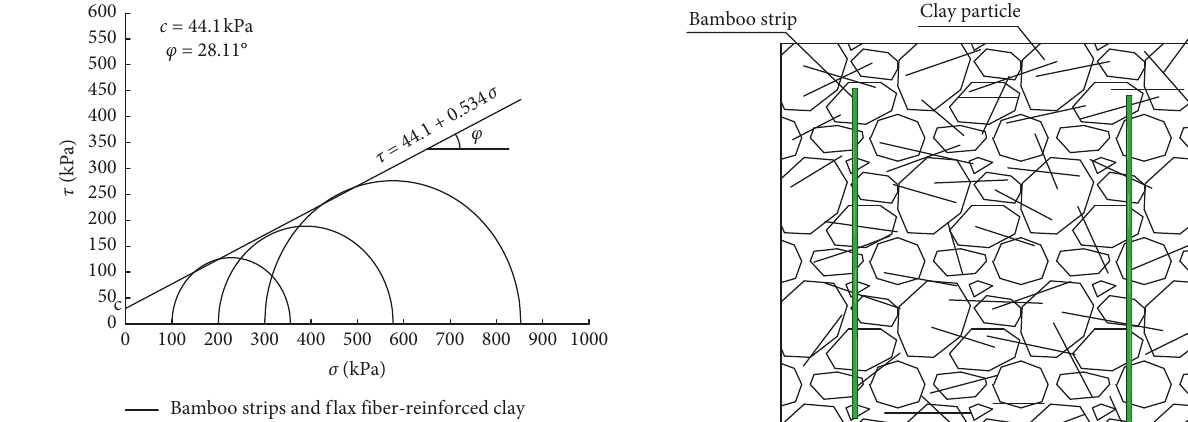
Figure 9: Mohr stress circle envelope of bamboo strips and flax fiber-reinforced Table 3: Shear strength parameters. Materials